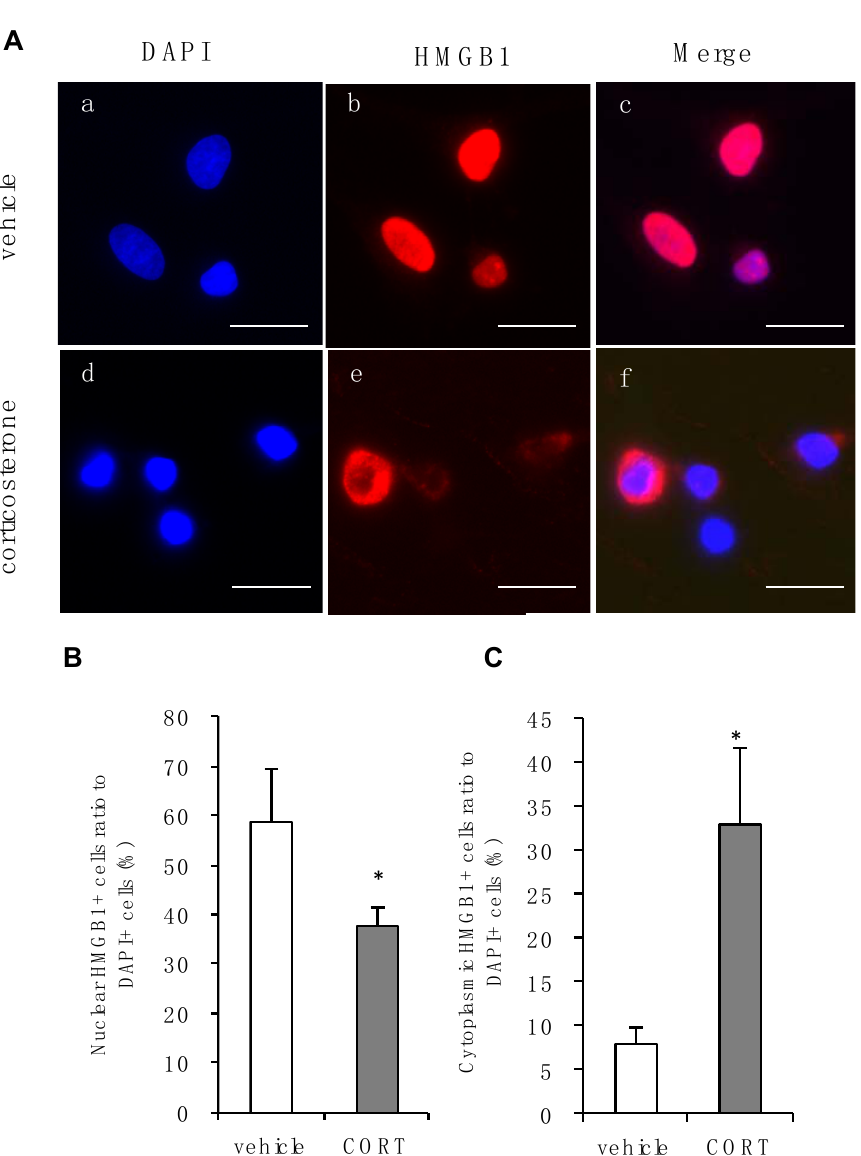
Figure 3. E ff ects of corticosterone on intracellular localization of HMGB1 in primary cultured cortical astrocytes. ( A ) Immunocytochemistry of HMGB1 in rat primary cultured cortical astrocytes. Corticosterone-treated cells (CORT; 1 µ M, 24 h) exhibited subcellular HMGB1 expression compared with vehicle. Images a, b and c, or d, e and f, are from the same fields, respectively. Scale bar = 20 µ m. ( B ) The percentage of nuclear staining of HMGB1 to total DAPI positive cells decreased after corticosterone treatment. The data are expressed as the mean ± SEM. * p < 0.05 vs. vehicle ( t -test; n = 3–4). ( C ) The percentage of cytoplasmic staining of HMGB1 to total DAPI positive cells increased after corticosterone treatment. The data are expressed as the mean ± SEM. * p < 0.05 vs. vehicle ( t -test; n = 3–4).